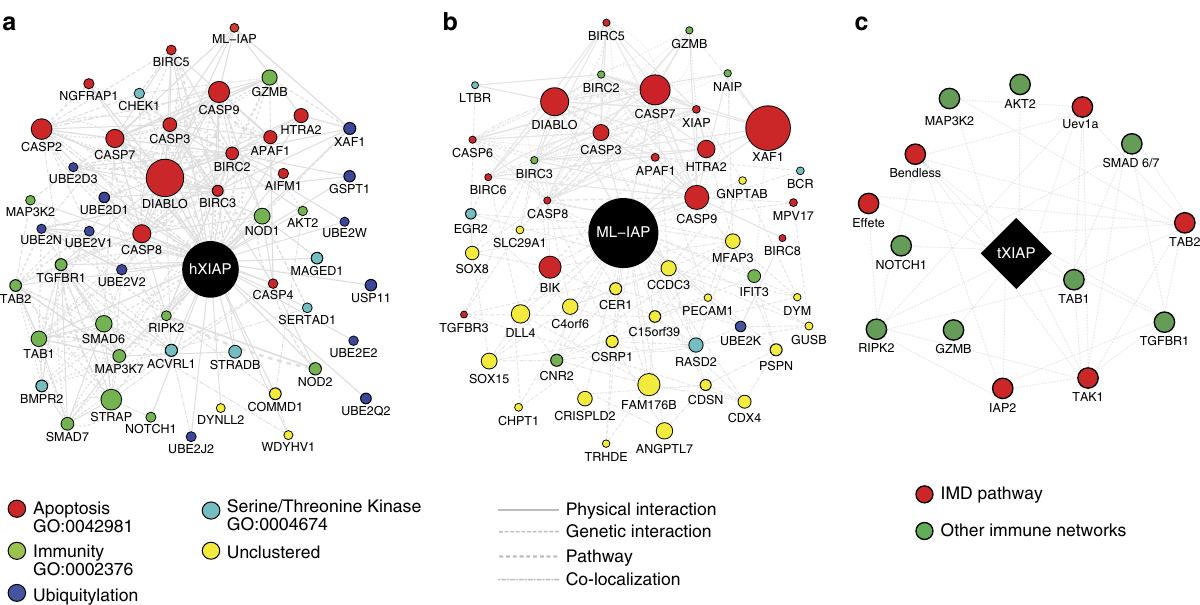
Figure 1 | The I. scapularis XIAP interactome. Top 50 related genes interacting with the human ( a ) XIAP and ( b ) ML-IAP were compiled in a network according to GeneMANIA. Interactomes were visualized by using Cytoscape. Networks and biological pathways were integrated based on previously observed protein and genetic interactions, pathway, and co-localization assays. Proteins were grouped according to the GO functional categories available at DAVID. Size corresponds to the score given to each node. Edge type is based on the interaction map. Width is determined by scored evidence of interaction. ( c ) I. scapularis homologues were obtained with PSI-BLAST and GeneCard searches based on the human XIAP or the ML-IAP interactome. Sixty-eight candidates were grouped according to the GO functional categories available at DAVID. Immunity genes are represented in green and all candidates highlighted in red are predicted to be involved in the arthropod IMD pathway. See also Supplementary Figs 1–4 and Supplementary Table